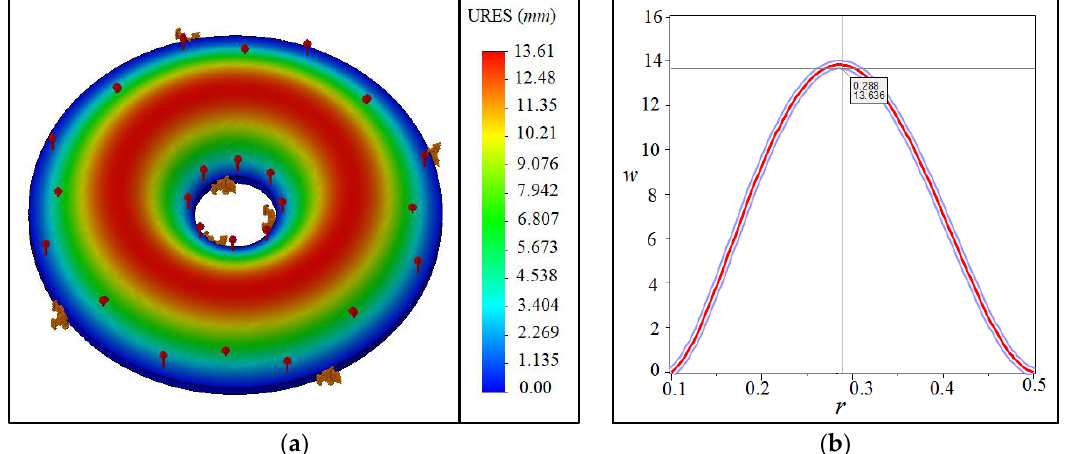
Figure 4. Deflection results of ( a ) ABAQUS software and ( b ) the present study.